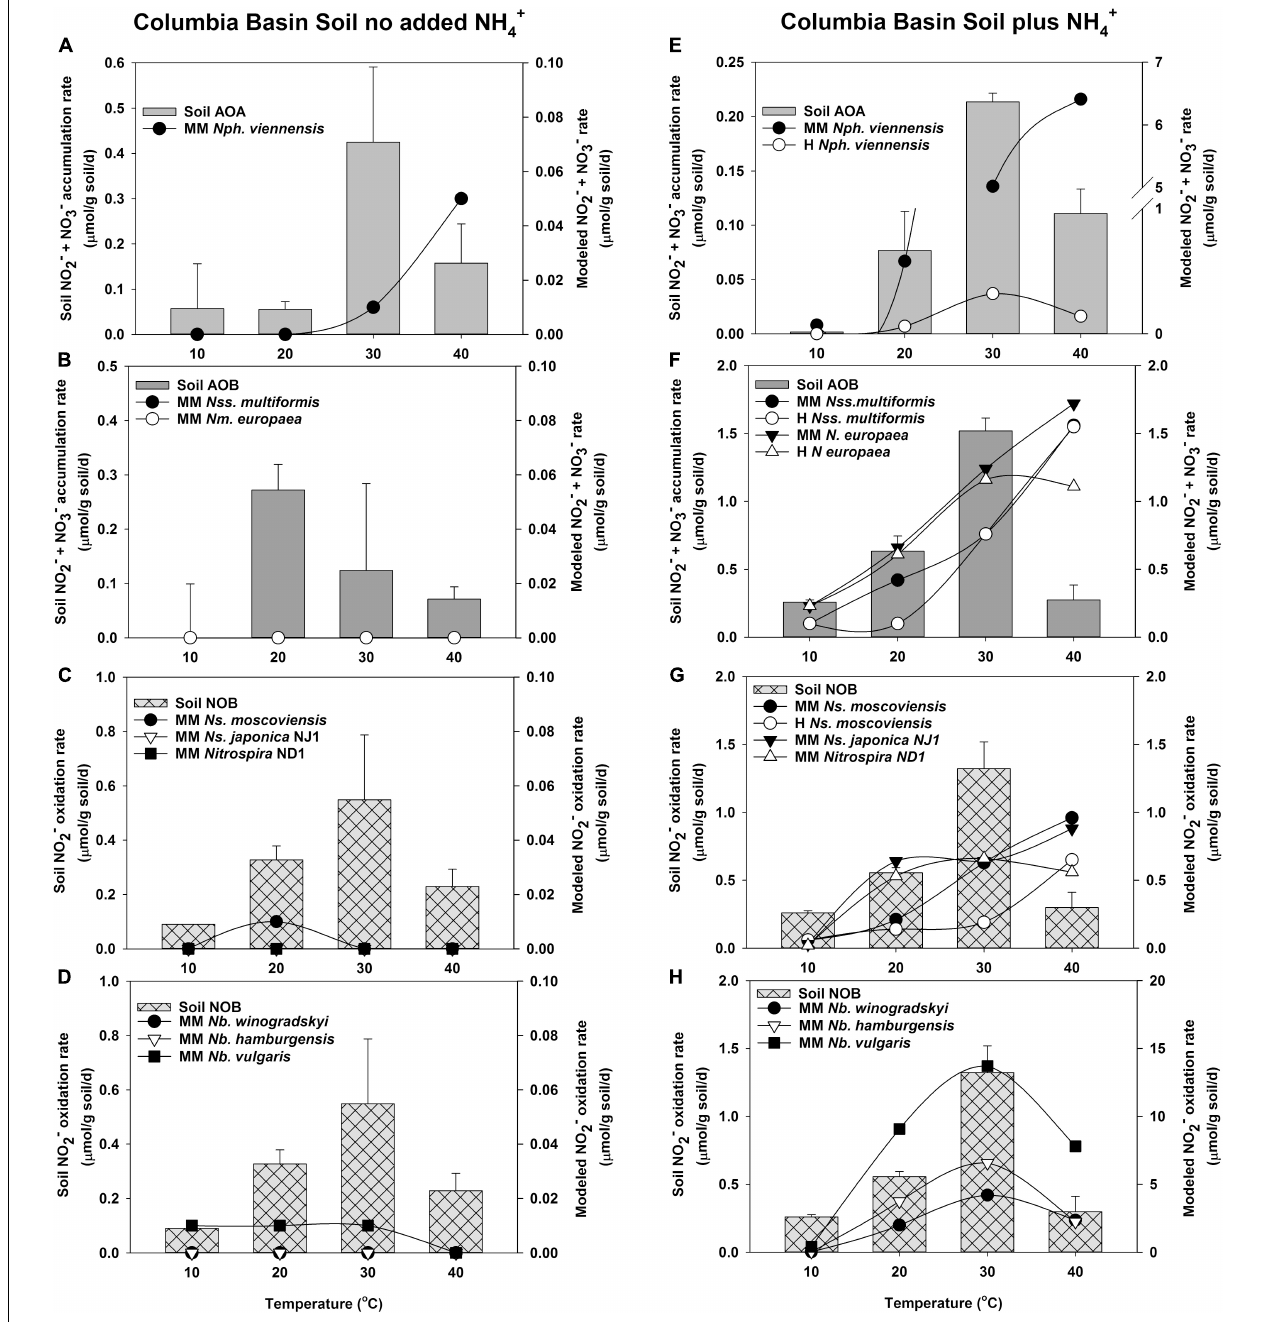
FIGURE 4 | Comparison of the potential response of AOA, AOB, and NOB cultures evaluated with the response of soil nitrifiers in short-term (24 h) incubations of Columbia Basin soil with no NH 4 + addition (A–D) , and with NH 4 + addition (5 µ mol/g soil, E–H) . The soil nitrifier response measured during incubations is indicated by the bars corresponding to the left y -axis, and the response modeled using the kinetics of nitrifier cultures determined in this study ( Supplementary Table 5 ) is indicated by the symbols corresponding with the right y -axis. Individual nitrifier names are preceded by MM or H to indicate that MM or H parameters, respectively, were used to calculate the potential rates of